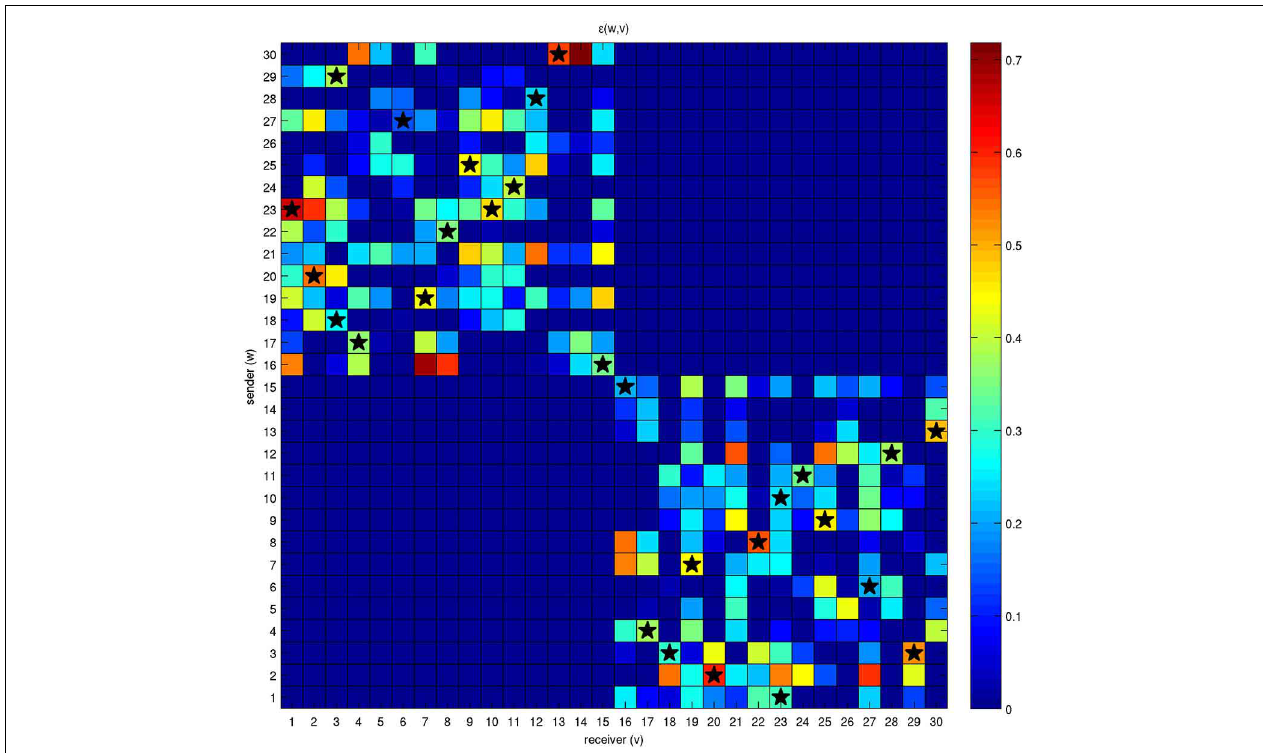
FIGURE 4 | Energy initially available for exchange among a network of 30 bacteria. Each bacterium has a quantity of energy available it wants to transfer to the others and it will be allowed to receive an amount of energy from them. These two energies are represented by different colors in the rows and columns of the grid. For example, bacterium 23 wants to share a large amount of energy with bacterium